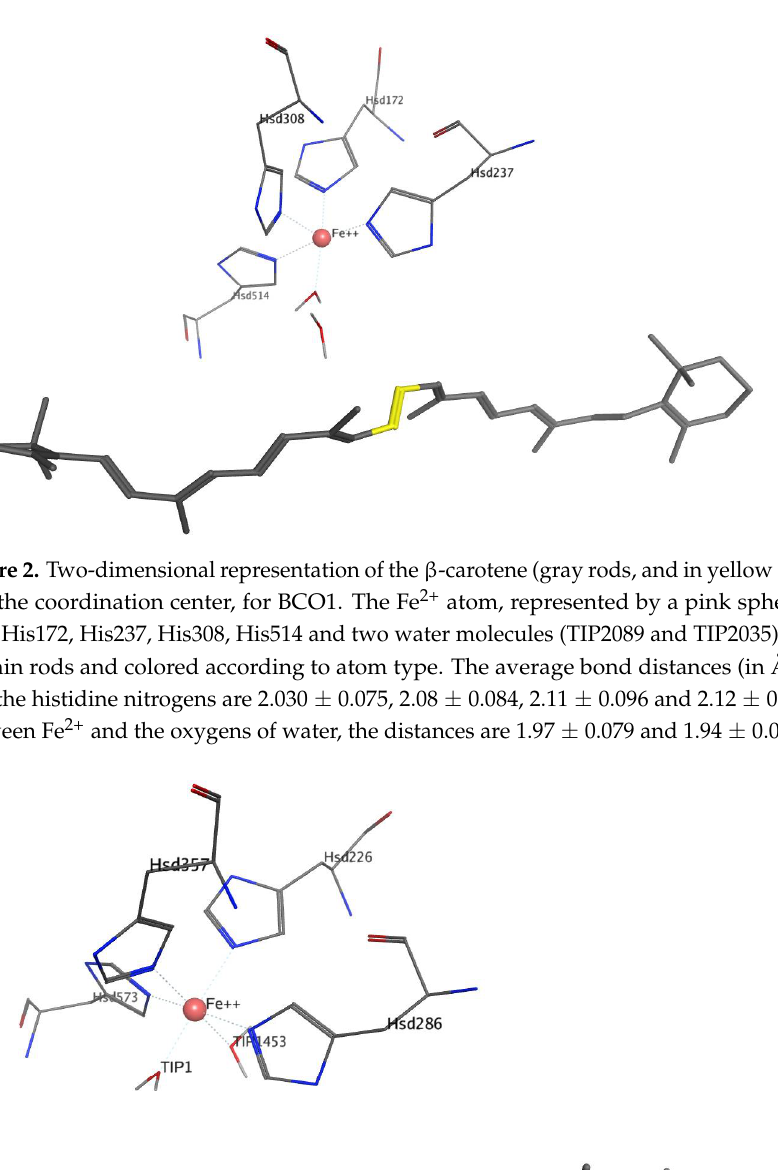
Figure 1. Three-dimensional ribbon display of the BCO1 structure. The beta-sheets colored in light green, light blue, violet, mustard, orange, dark green and brown can be distinguished. The alpha helices are shown in red, and the loops are shown in thin gray lines. The representation of the ligand in gray rods and of the metal in pink is shown in the center.